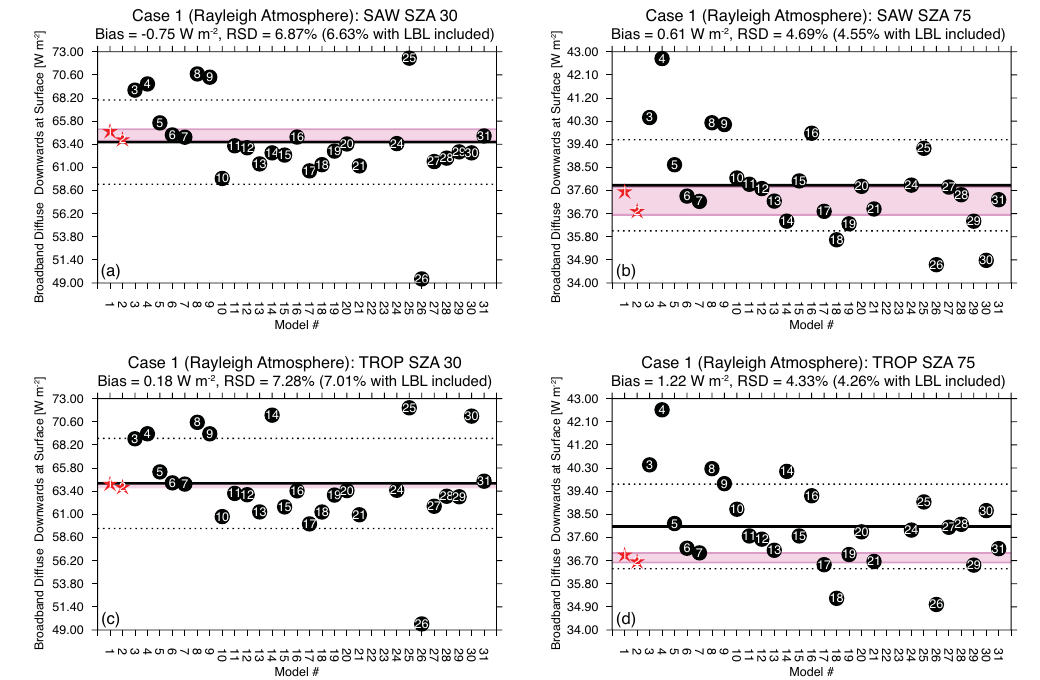
1 standard deviation indicated by dotted black lines. The model bias relative to the LBL-mean is ± given as well as the relative standard deviation (RSD) excluding (and in parenthesis including) the LBL models. See Appendix Table A2 for additional statistics.